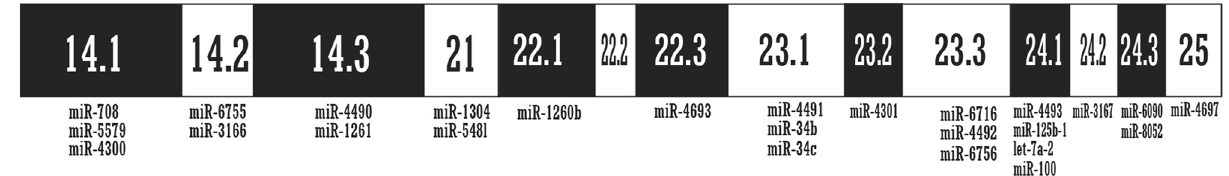
Figure 1. Map of chromosome 11q14-qtel with miRNA genes. The map shows the chromosomal positions of 26 miRNA genes within 11q14-qtel